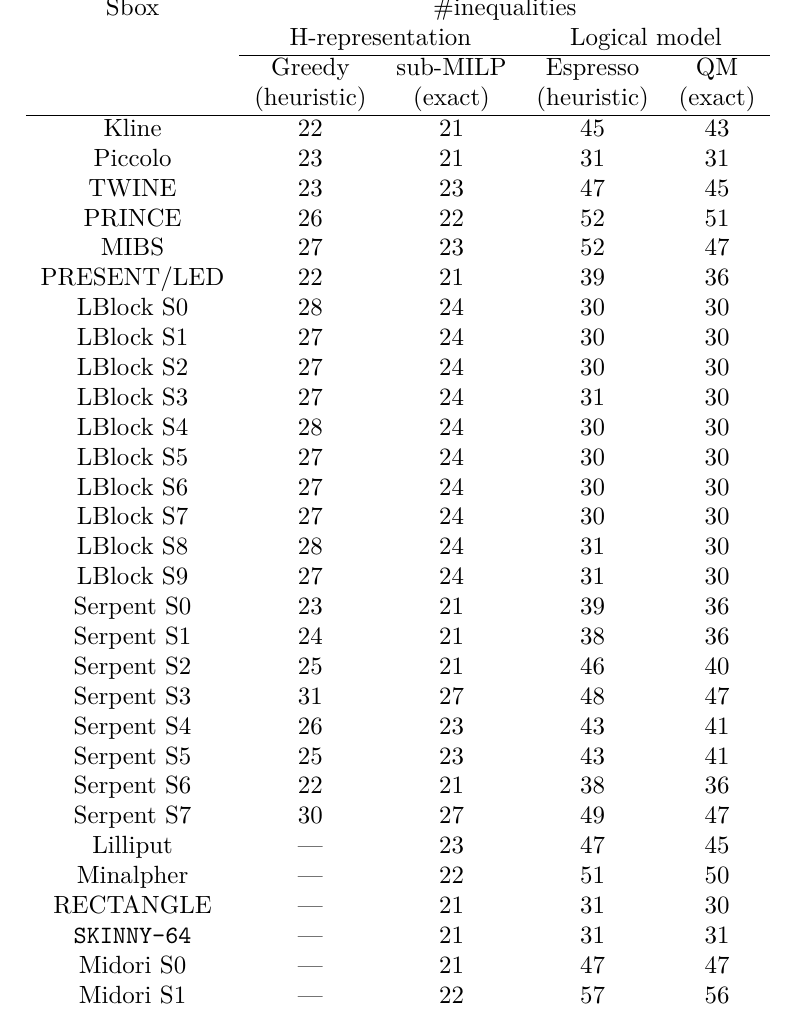
Table 10: Number of Inequalities to Describe the ∗ -DDT of Various 4-bit